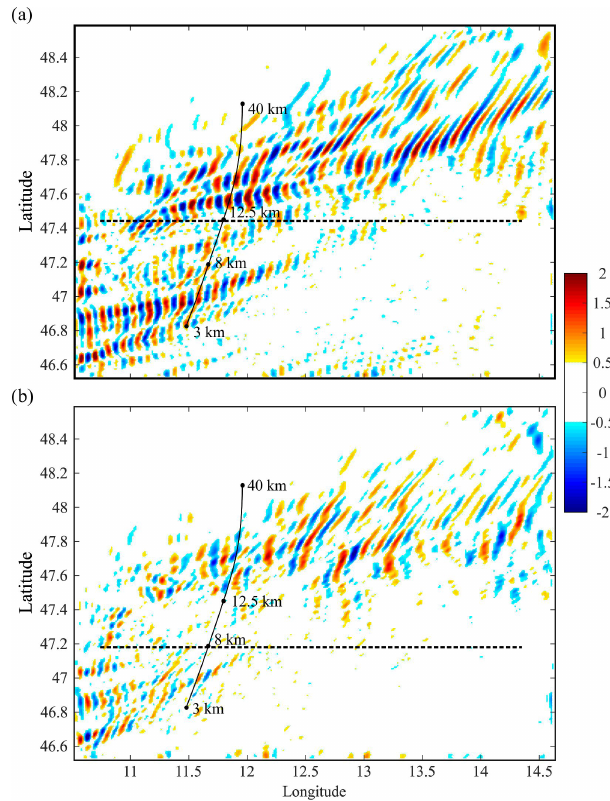
Figure 4. Simulated high-resolution (inner WRF domain) δw struc- tures in the Alps region (defined in Fig. 1). Two altitude levels, (a) above and (b) below the clouds top, are shown. The line of tangent points (LTP) corresponding to the collocated RO event is indicated in both panels from lower (3km) to upper (40km) points (solid black line). The line of sight (LOS, dotted black line) at both levels is also